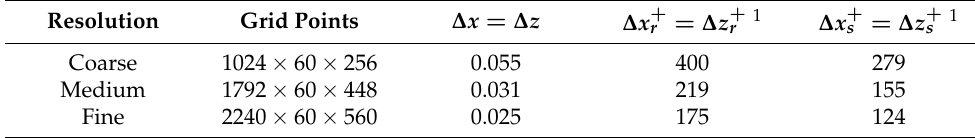
Table 1. WMLES grid-convergence study: summary of mesh